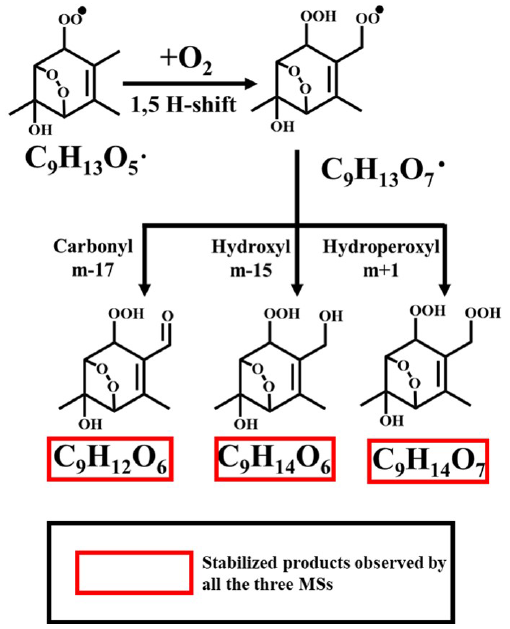
Scheme 1. A proposed autoxidation reaction scheme involving a bicyclic peroxy radical of C 9 H 13 O 5